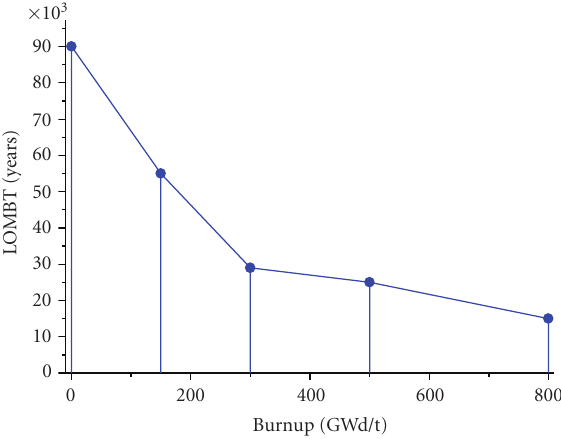
Figure 6: LOMBT versus Burn-up (2/3 Th – 1/3 Pu) [4].